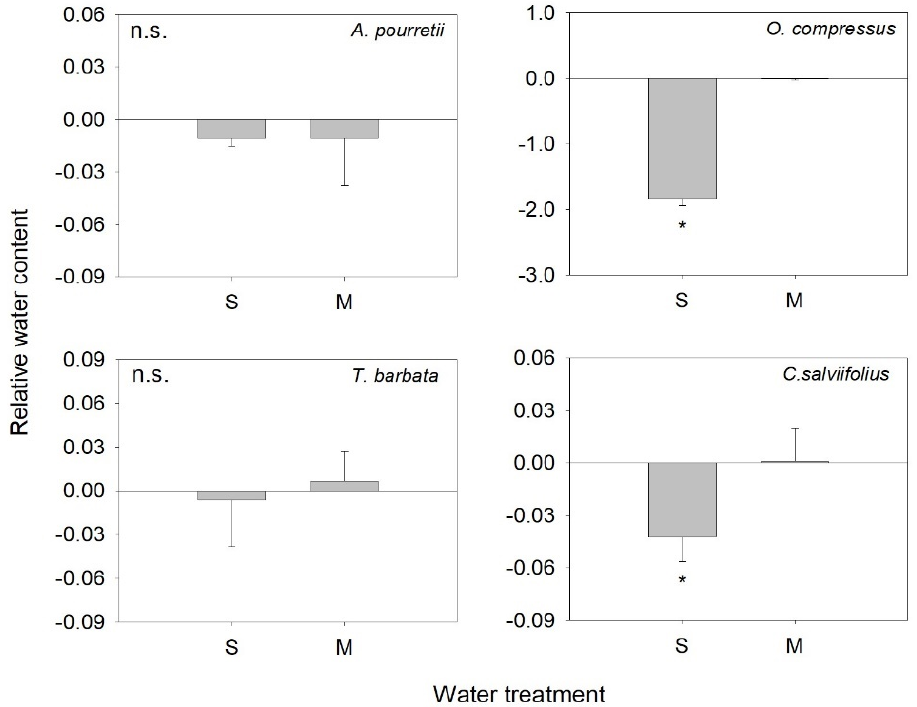
Figure 1. Response ratio (mean values + SE) for the response ratio of the relative water content of Agrostis pourretii , Ornithopus compressus , Tolpis barbata and Cistus salviiflolius under severe water deficit (S) and moderate water deficit (M). The presence of * indicates that the response ration differed significantly from zero. n.s., not significant. Table 1. Results from the one-way ANOVA testing for the effect of water treatment (severe water deficit, moderate water deficit and control) on the response of morphological and physiological traits measured. Significant p values ( p < 0.05) are highlighted in